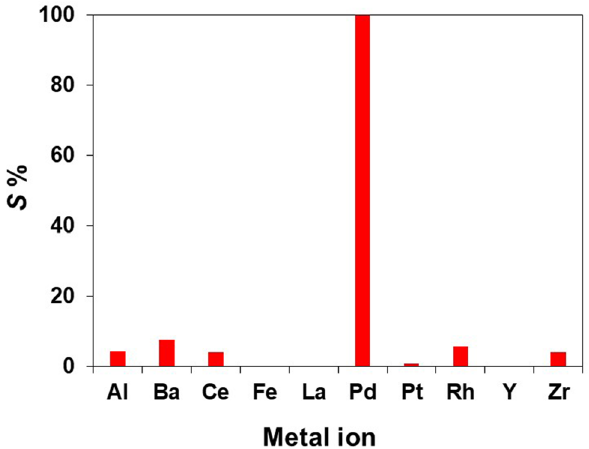
Figure 7. Sorption of Pd(II) from a spent automotive catalyst leachate containing 10 metals (Al, Ba, Ce, Fe, La, Pd, Pt, Rh, Y, and Zr) by 1 -EIR. Adsorption conditions: 1 -EIR = 0.1 g; pH = 0.5; shaking speed = 280 rpm; shaking time = 4